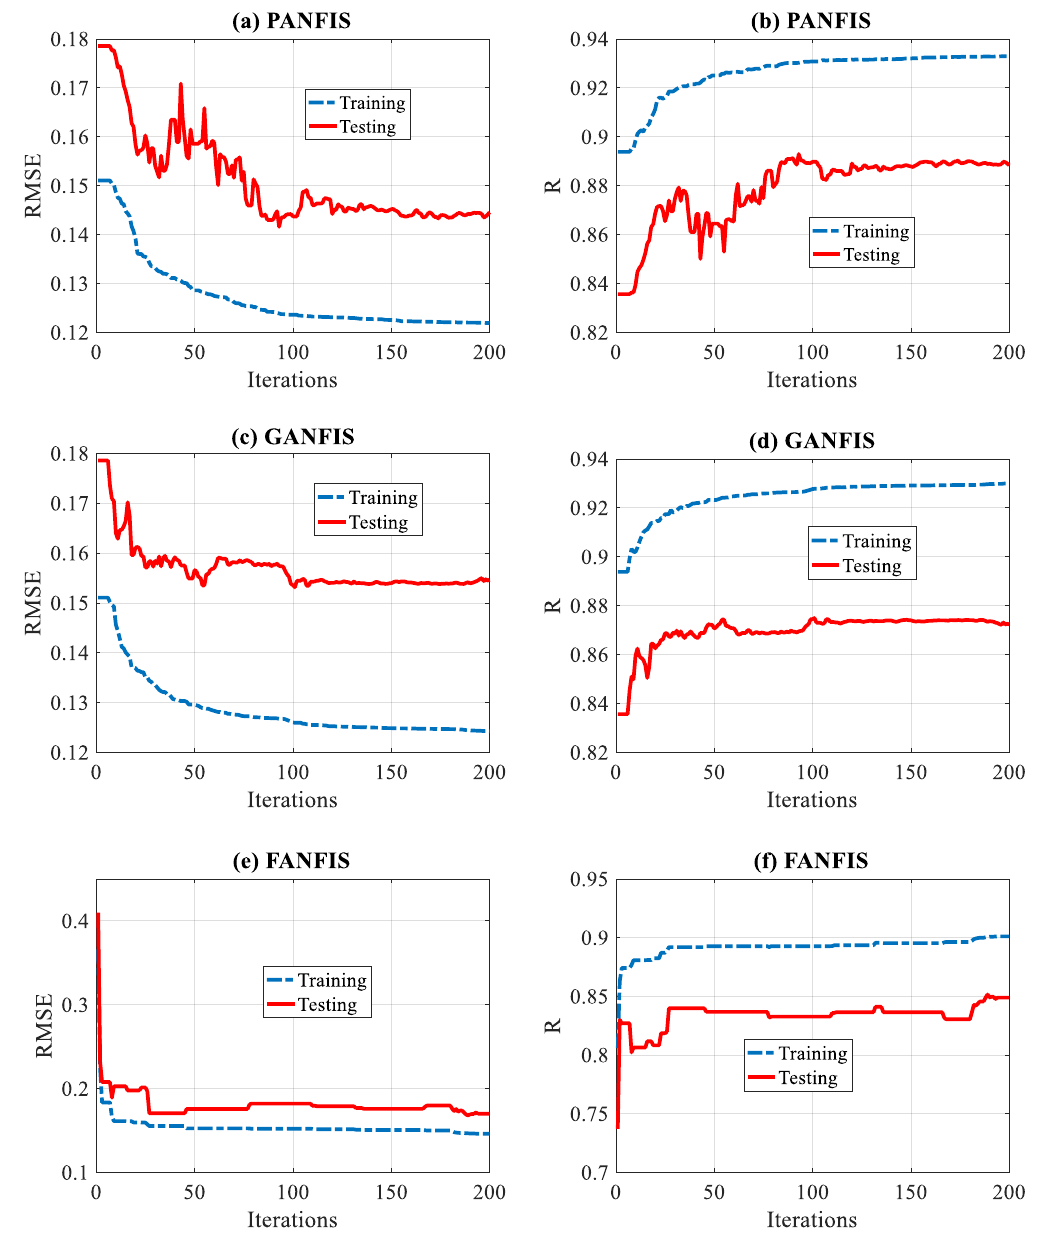
Figure 5. Cost functions when using metaheuristic optimization techniques: Particle swarm optimization: ( a ) root mean square error (RMSE), ( b ) R; genetic algorithm: ( c ) RMSE, ( d ) R and firefly algorithm: ( e ) RMSE, ( f ) R.